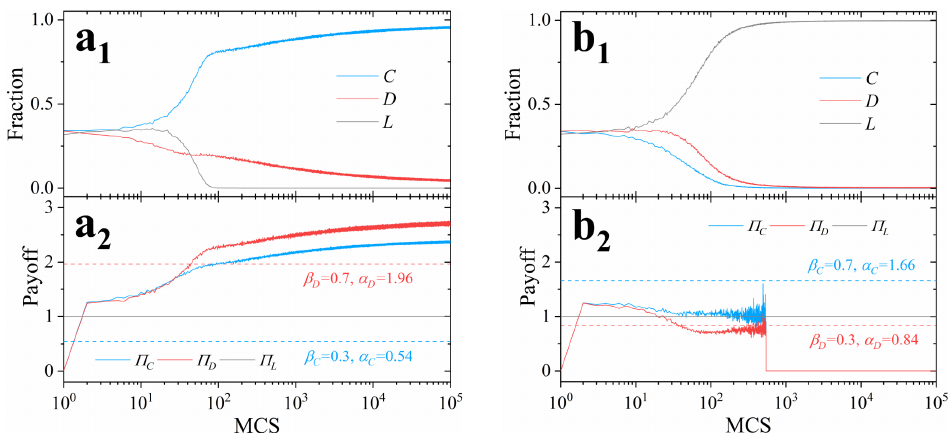
Figure 8. Evolutionary processes of strategies ( 𝑓 ( Π C , Π D , Π L ) for ( a 1 , a 2 ) β C = 0.3, β D = 0.7 and ( b 1 , b 2 ) β C = 0.7, β D = 0.3. The other parameters 𝛱 (cid:3005) , 𝛱 (cid:3013) ) for ( a 1 , a 2 ) 𝛽 (cid:3004) = 0.3 , 𝛽 (cid:3005) = 0.7 and ( b 1 , b 2 ) 𝛽 (cid:3004) = 0.7 , 𝛽 (cid:3005) = 0.3 . The other parameters are the are the same as in Figure same as in Figure 7.